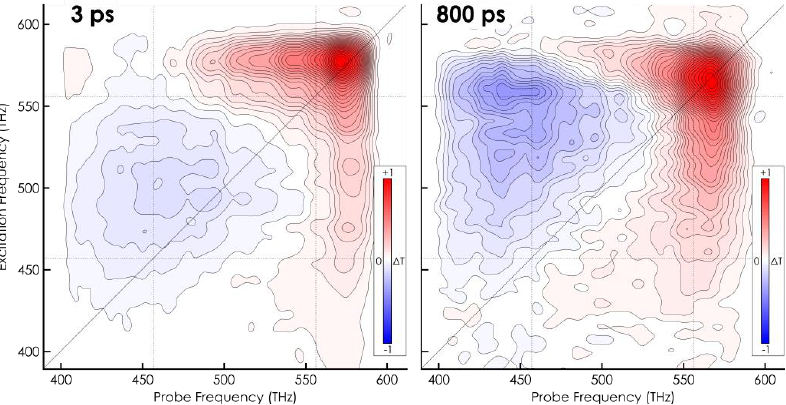
Fig. 2. The 2D electronic spectra of the ruthenium-based DSSC dye, N719, at waiting times of 3 ps and 800 ps. The dominant ESA feature at probe frequencies less than 500 THz shifts from the initially prepared state at 500 THz excitation to the excitation maximum of N719 as an approximately 20 ps transient species nonradiatively